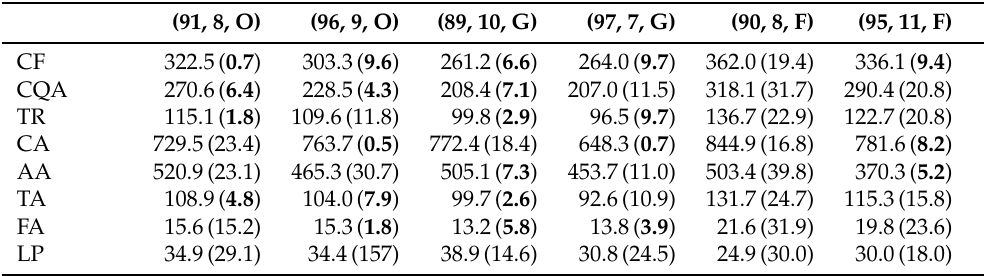
Table 10. Amount (mg) of the chemical species at the end of the percolation process for Robusta variety. The percentage error between numerical and laboratory results is in brackets. The extraction point is denoted by ( T , p , r )